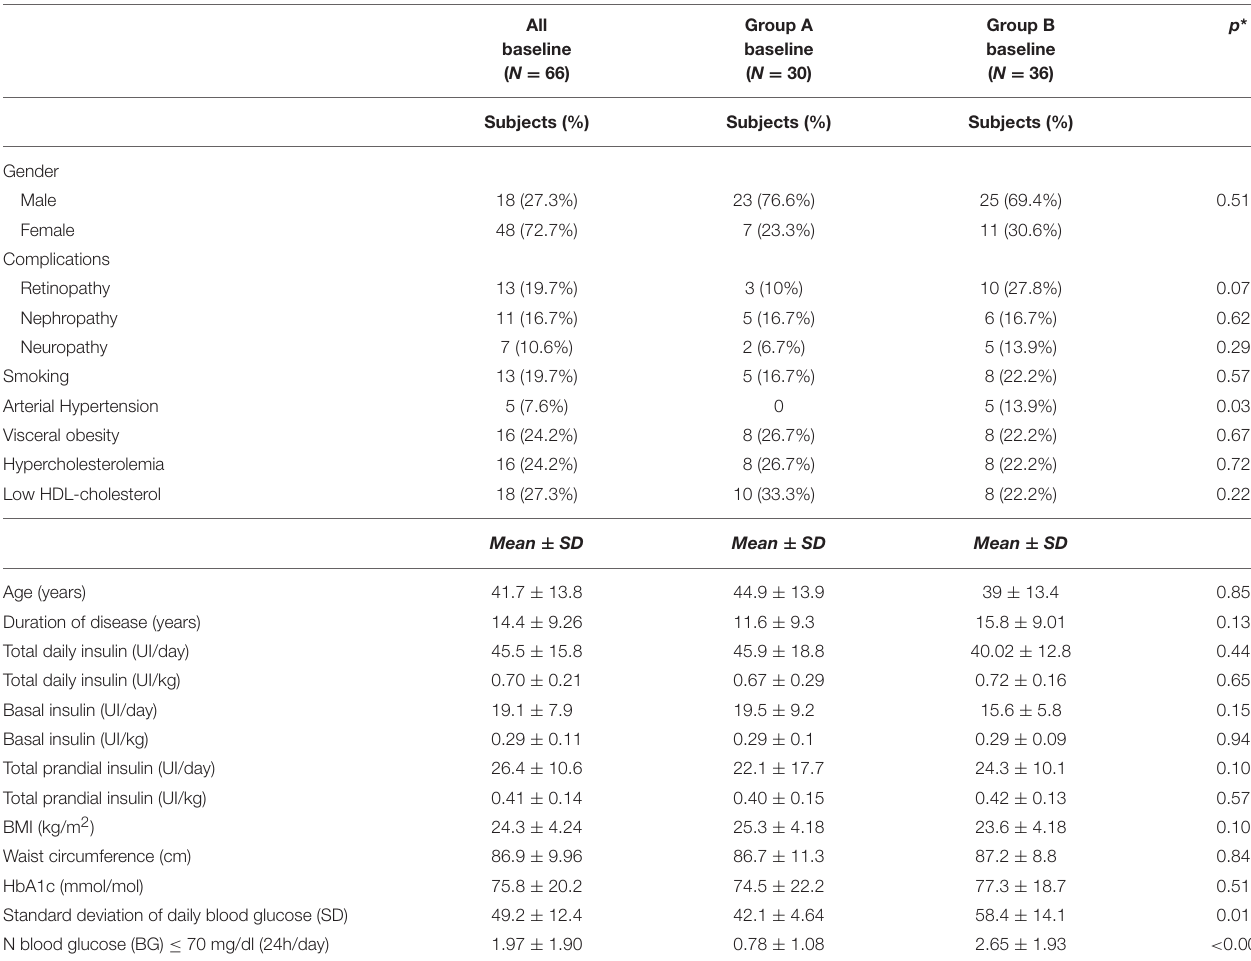
TABLE 1 | General characteristics of the two groups of patients at